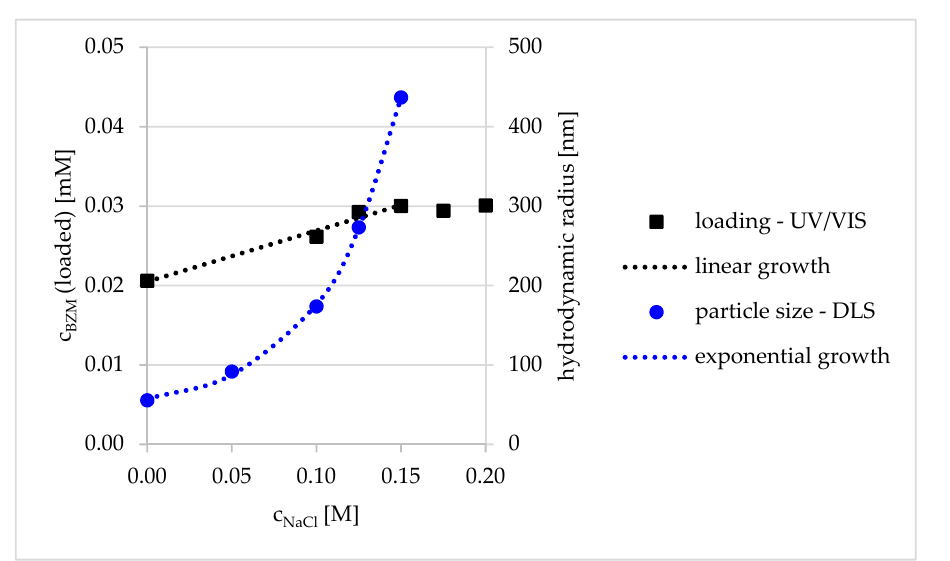
Figure 6. Linear increase of loading capacity and exponential particle growth of PDOPAC / PEC with rising salt concentration from 0–0.15 M NaCl in the dispersion.